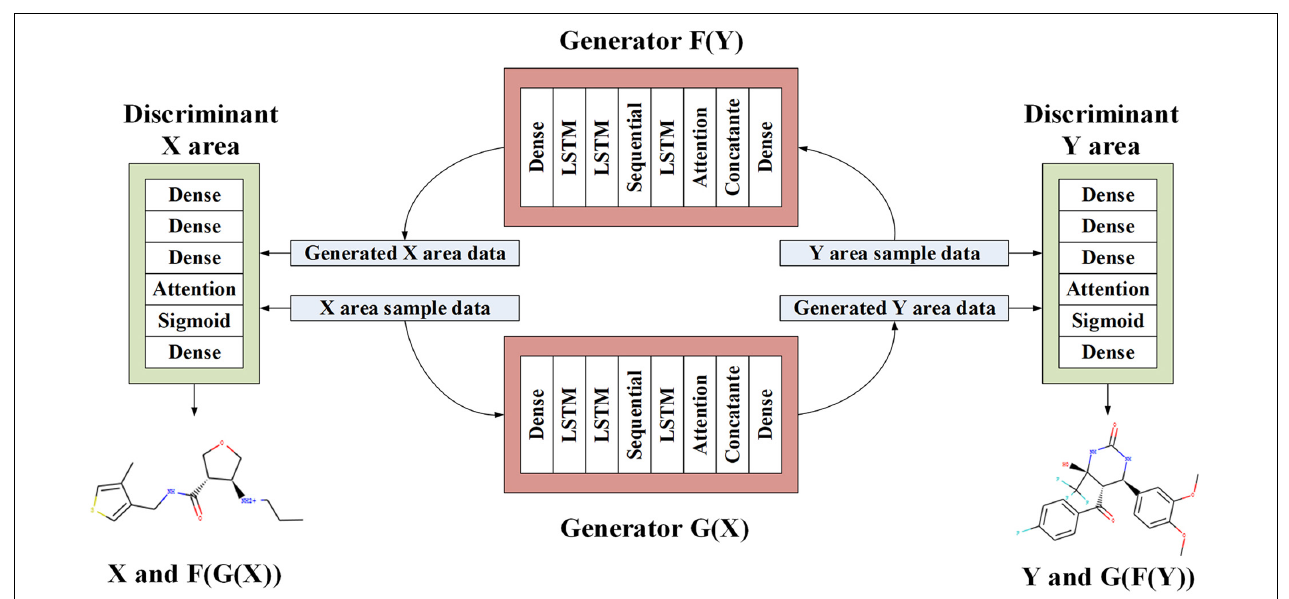
FIGURE 2 | The proposed architecture of LA-CycleGAN. LSTM with Attention mechanism are embedded in the generators.